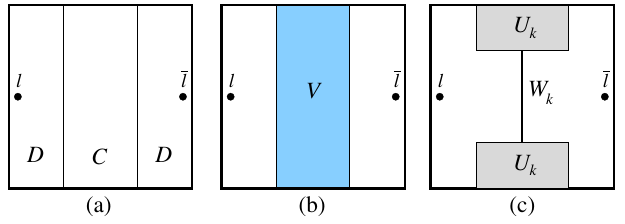
FIG. 6. Key steps in the argument. (a) We partition the L (cid:5) L system into two pieces C , D , where D has two connected (cid:3) l components—one containing l and one containing . (b) We P V 0 V 00 V 0 FIG. 7. (a) We write V ¼ show that there exists an operator V acting in region C such that i i (cid:2) i , where i acts in the 0 . (c) We show that we can replace V V j (cid:2) i ¼ j (cid:2) i and V j (cid:2) interior of the system and V 00 i acts near the boundary. (b) We ex i ¼ construct an operator P that acts within the region E and satisfies several properties. First, P j (cid:2) i ¼ j (cid:2) i . Second, if P is applied to a state with no excitations outside of E [ F 1 [ F 2 , it returns a state with no excitations outside of F 1 [ F 2 is created in the bulk and moved near the boundary.